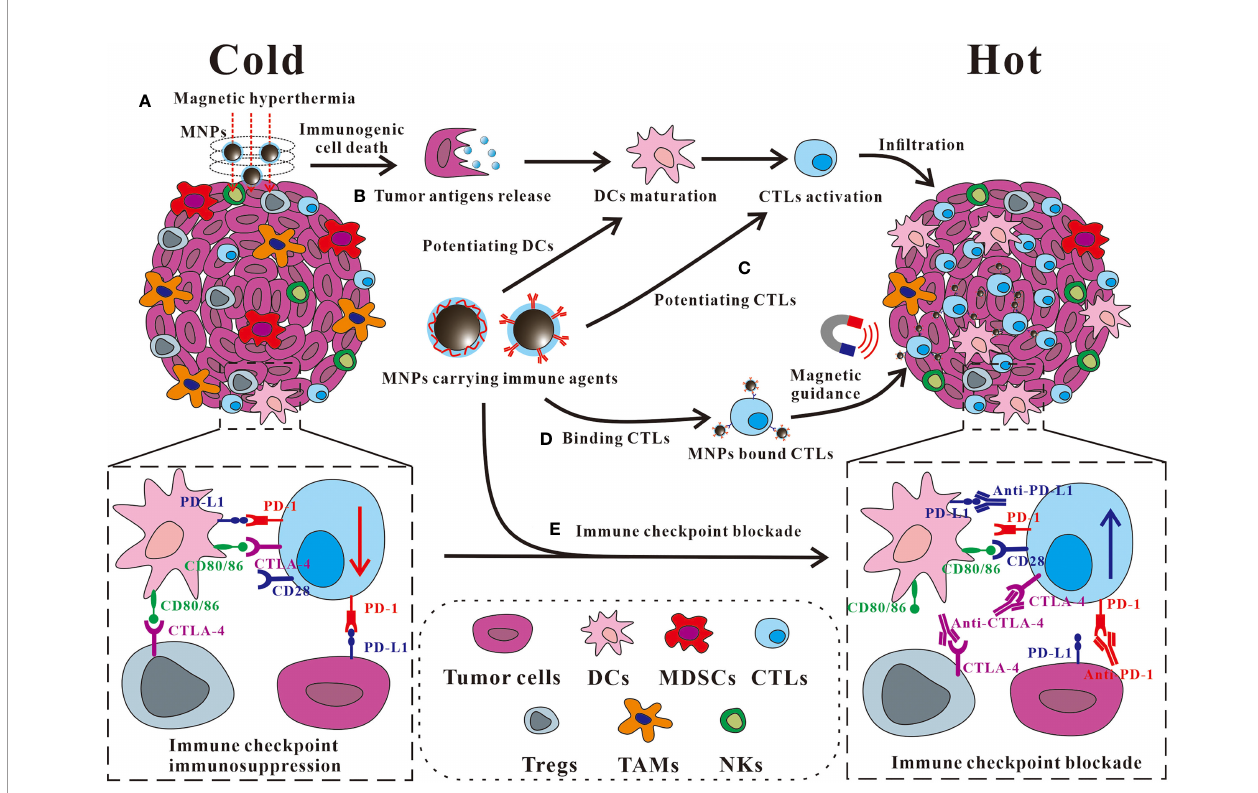
FIGURE 2 | Some representative approaches of MNPs to turn a “ cold ” tumor into “ hot ” . (A) MNP-based magnetic hyperthermia ablation therapy is capable of inducing tumor immunogenic cell death to promote the release of antigen for DC maturation, and the subsequent CTL activation and in fi ltration in the tumor. (B, C) MNPs carrying immune agents such as agonists can be applied (B) for potentiating DCs or (C) for potentiating CTLs. (D) MNPs carrying immune agents such as antibodies can bind CTLs, and direct them to the tumor with an improved accumulation and in fi ltration by the magnetic guidance. (E) The tumor accumulation of the immune checkpoint antibody can be enhanced by the conjugation on MNPs for an improved immunosuppressive pathway modulation with fewer adverse effects. DCs, dendritic cells; MDSCs, myeloid-derived suppressor cells; CTLs, cytotoxic T lymphocytes; Tregs, regulatory T cells; TAM, tumor-associated macrophages; NKs, natural killer cells; PD-1, programmed cell death protein 1; PD-L1, programmed cell death ligand 1; CTLA-4, cytotoxic T lymphocyte-associated protein